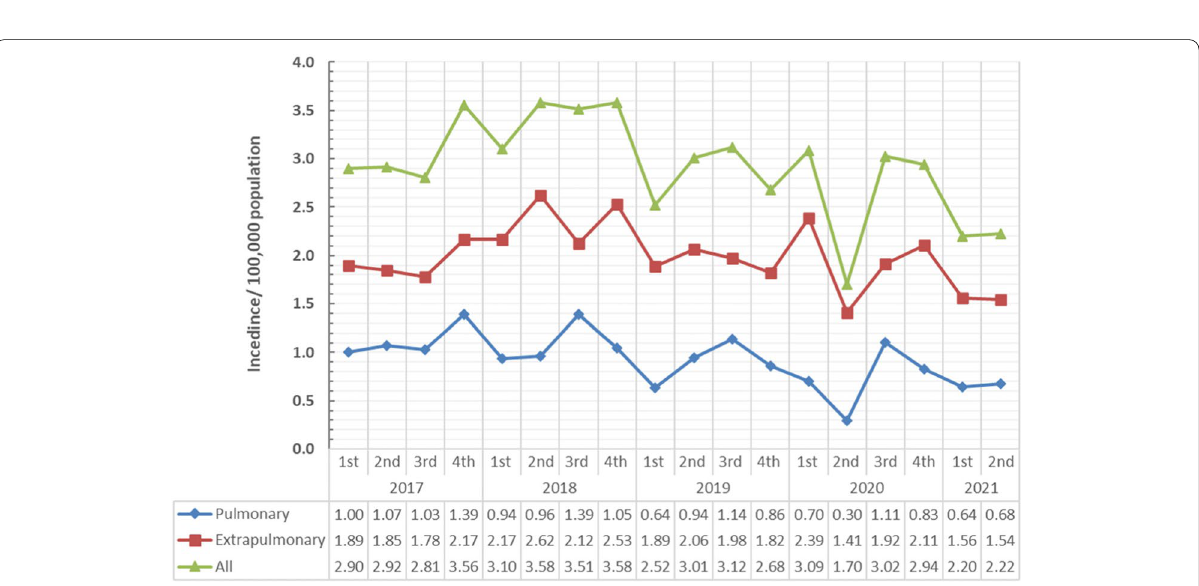
Fig. 2 TB incidence over quarters of years (2017–2021) in Assiut Chest Hospital,